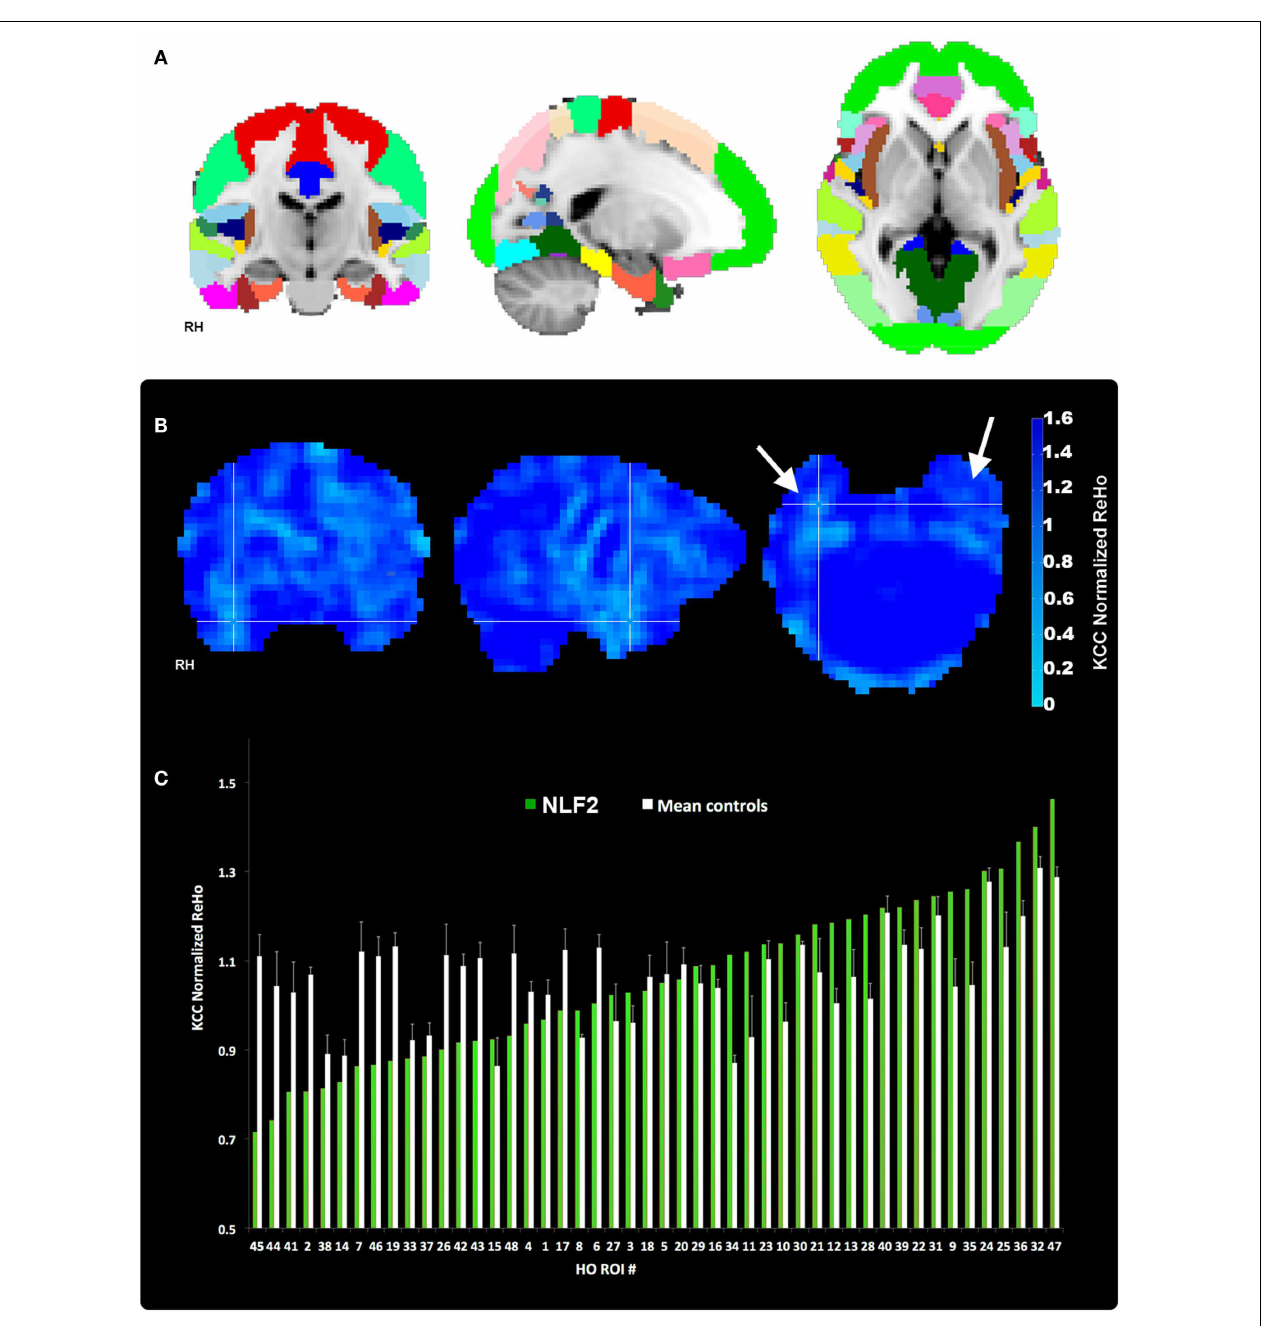
hemisphere, an effect that is absent from the left. (C) Plots raw normalized ReHo values across the 48 HO ROIs for the same NLF subject (green bars) and the mean of the four age- and gender-matched control subjects (white bars). Epilepsy and control values are sorted from lowest to highest for the NLF subject. In this NLF subject, the ROI that contains the epileptogenic zone (ROI 38) has one of the five lowest mean normalized ReHo values of all ROIs.